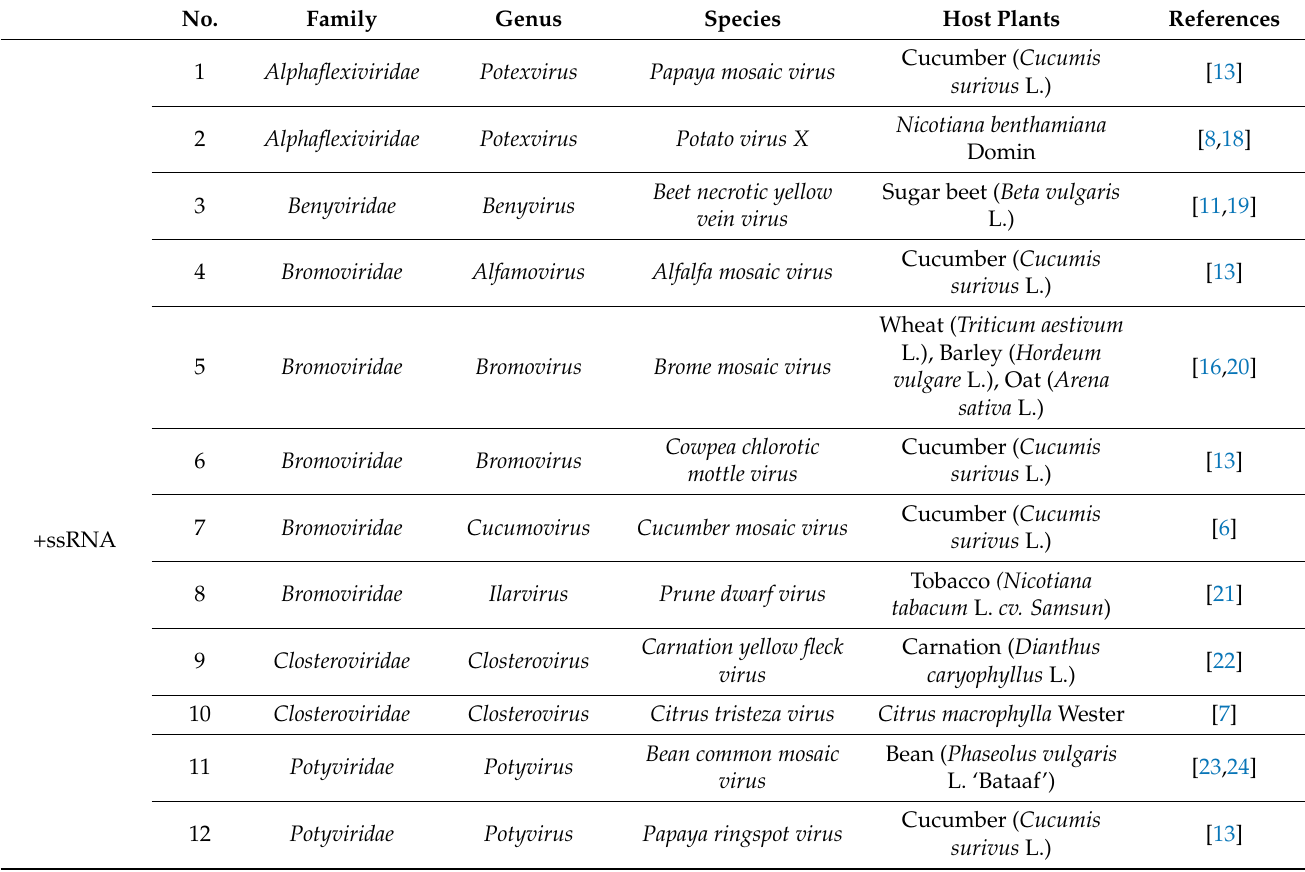
Table 1. Current list of viruses found in the xylem of herbaceous and perennial plant hosts.